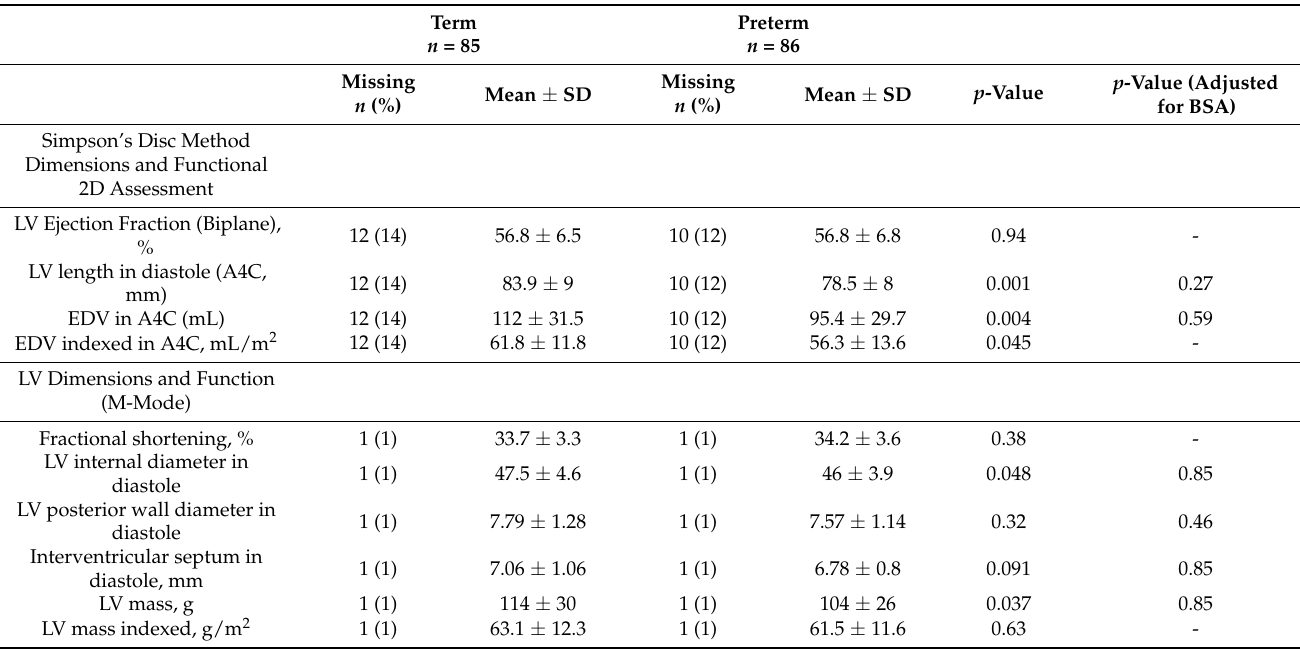
Table 2. Left Echocardiographic Structure and Function.